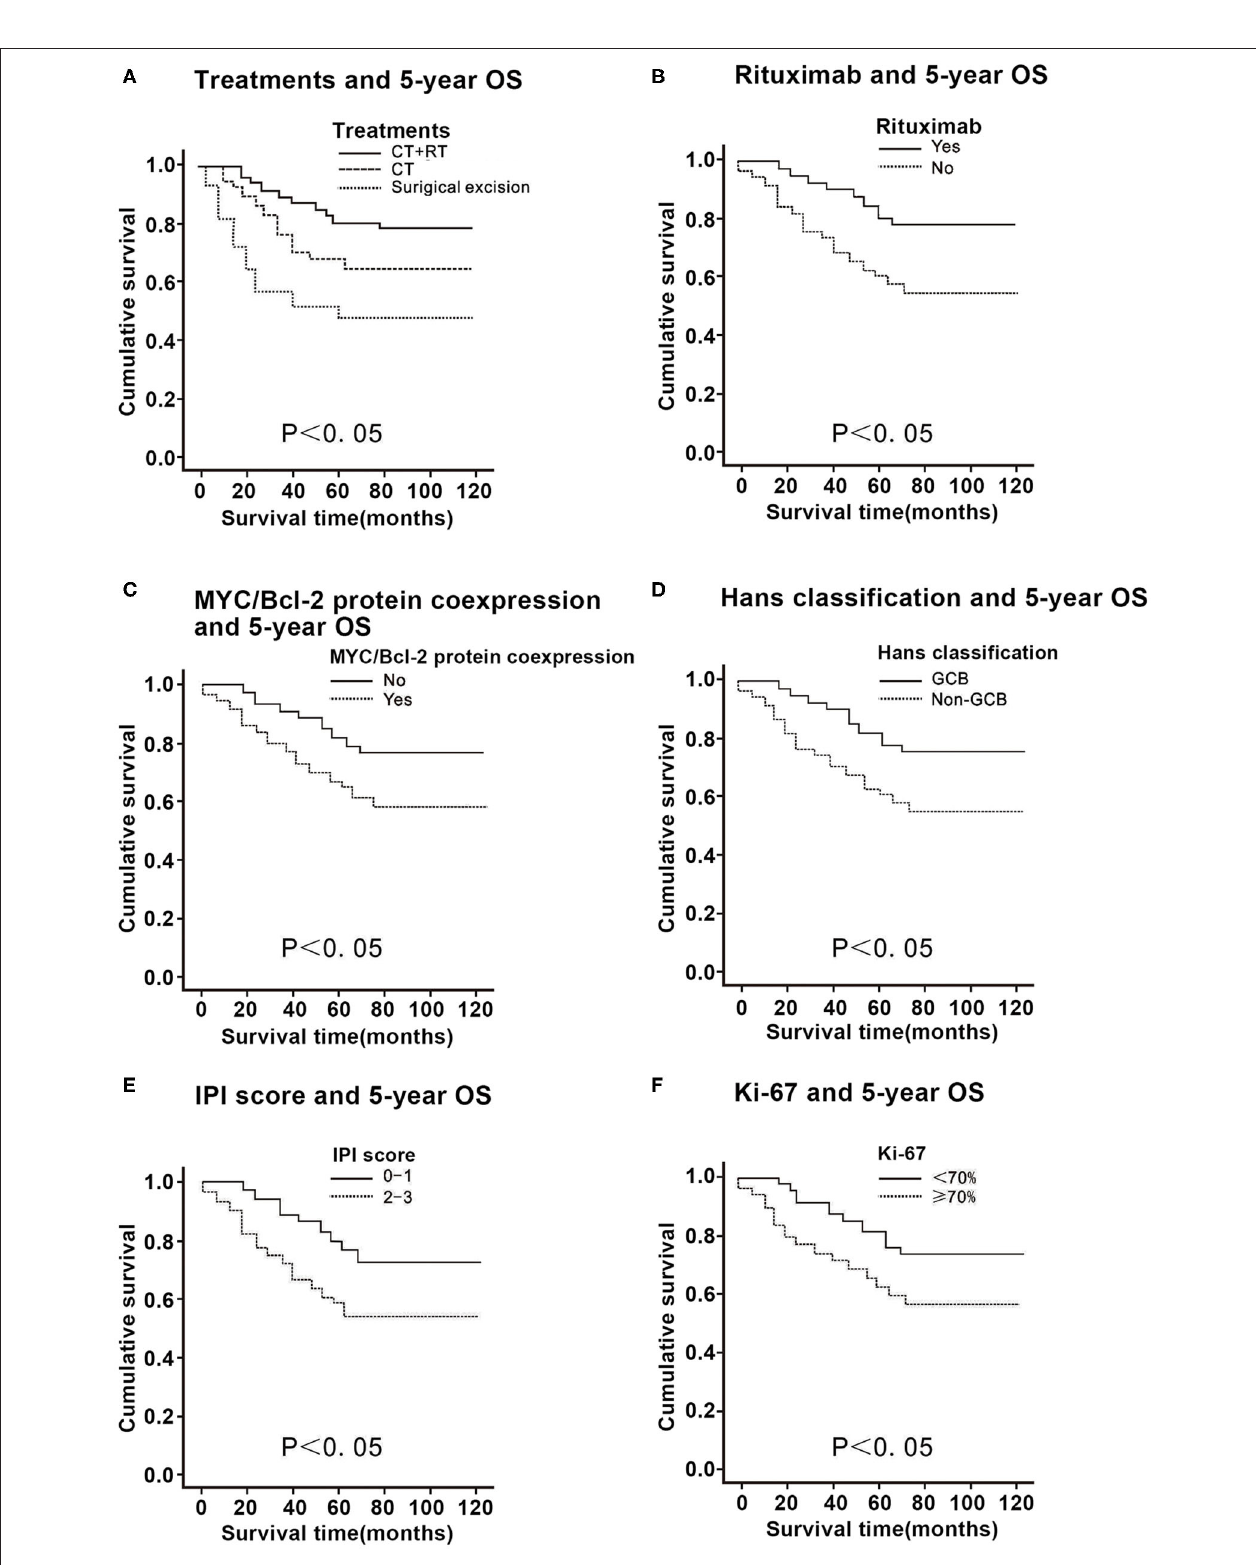
FIGURE 1 | Correlation of the 5-year overall survival (OS) with the clinicopathological features in 58 patients with primary thyroid diffuse large B cell lymphoma. (A) Comparison of the 5-year OS in patients with primary thyroid DLBCL according to treatments. (B) Comparison of the 5-year OS in patients with primary thyroid DLBCL according to rituximab. (C) Comparison of the 5-year OS in patients with primary thyroid DLBCL according to Myc/Bcl-2 protein co-expression. (D) Comparison of the 5-year OS in patients with primary thyroid DLBCL according to Hans classification. (E) Comparison of the 5-year OS in patients with primary thyroid DLBCL according to the international prognostic index (IPI) score. (F) Comparison of the 5-year OS in patients with primary thyroid DLBCL according to Ki-67 expression.